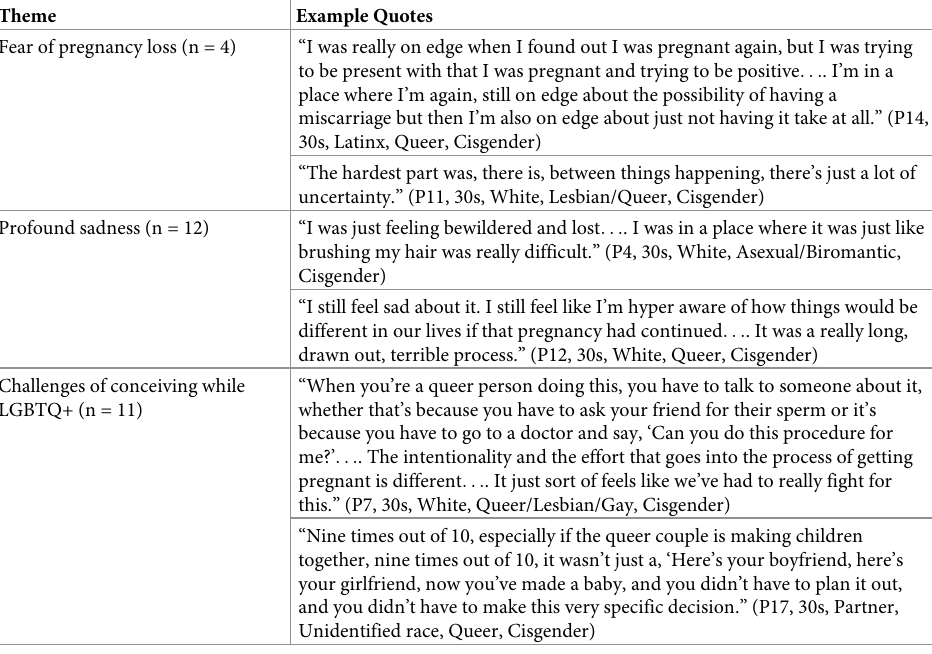
Table 2. Broad context of LGBTQ+ conception, pregnancy, and loss sub-themes, definitions, and